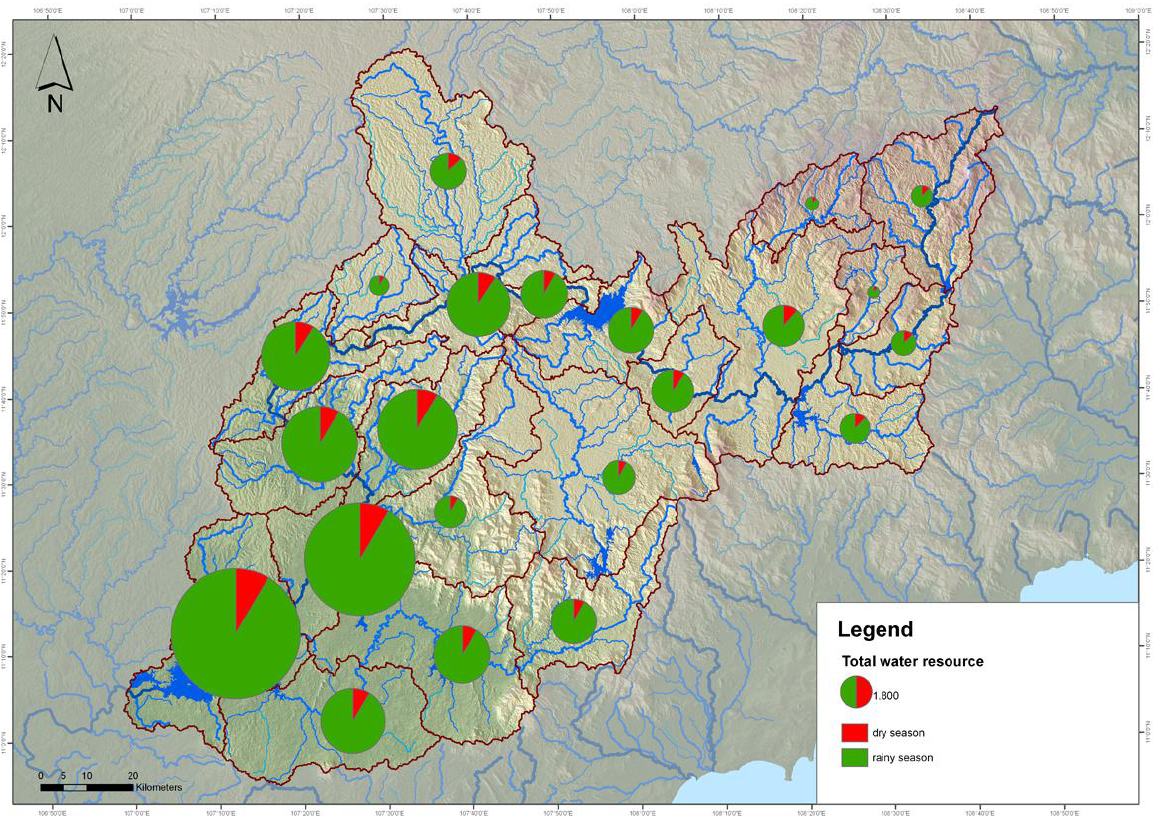
Figure 6. Amount of water resource in the